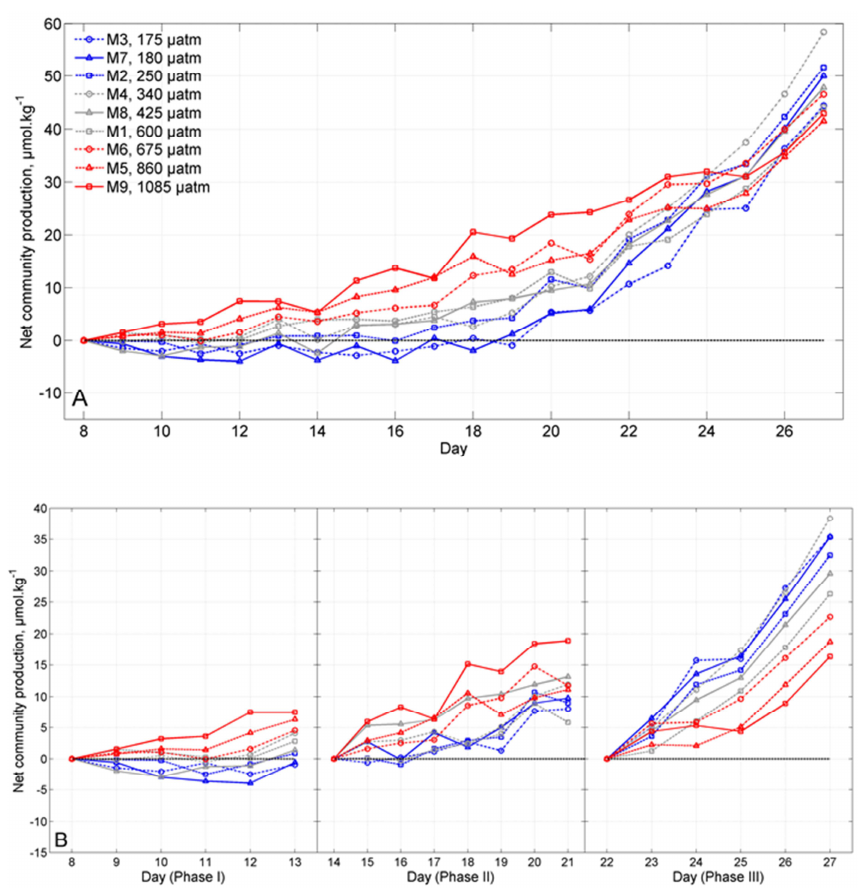
Fig. 5. (A) Net community production for the total period of the experiment; (B) net community production in every phase of the experiment. Horizontal dashed line on both figures shows the border between heterotrophic (below 0) and autotrophic (above 0) systems. Line colours and numbers in a legend are as described for Fig.